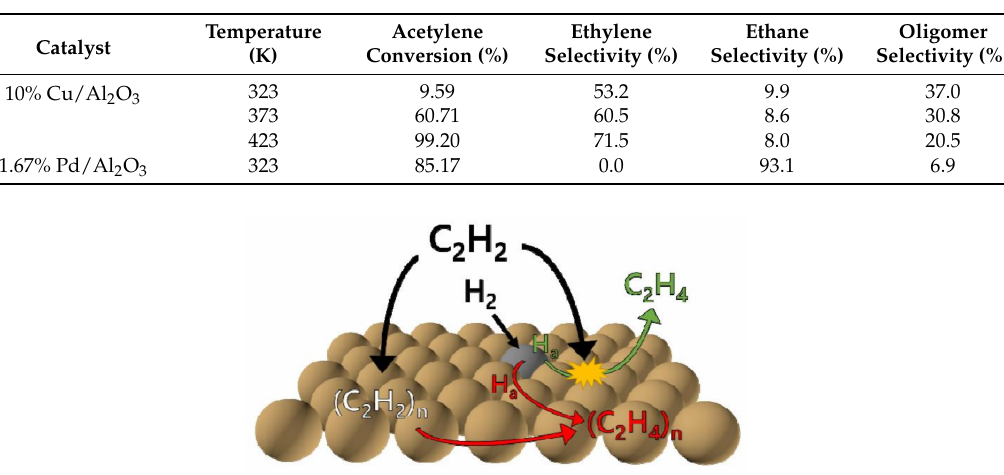
Table 2. Acetylene conversion and ethylene/ethane/oligomer selectivities over 10% Cu/Al 2 O 3 and 1.67% Pd/Al 2 O 3 .